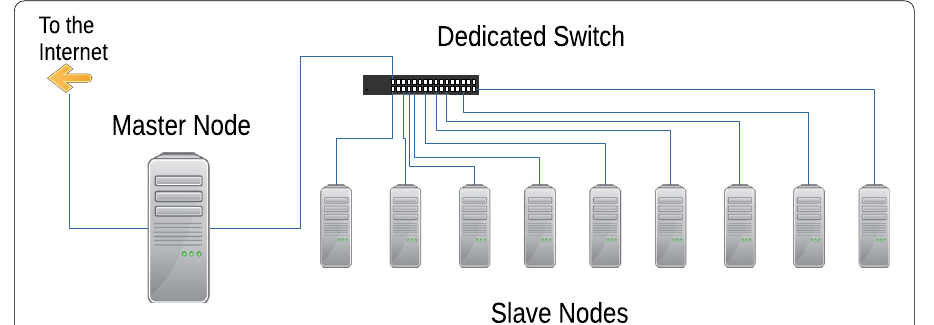
Fig. 3 Hadoop cluster nodes